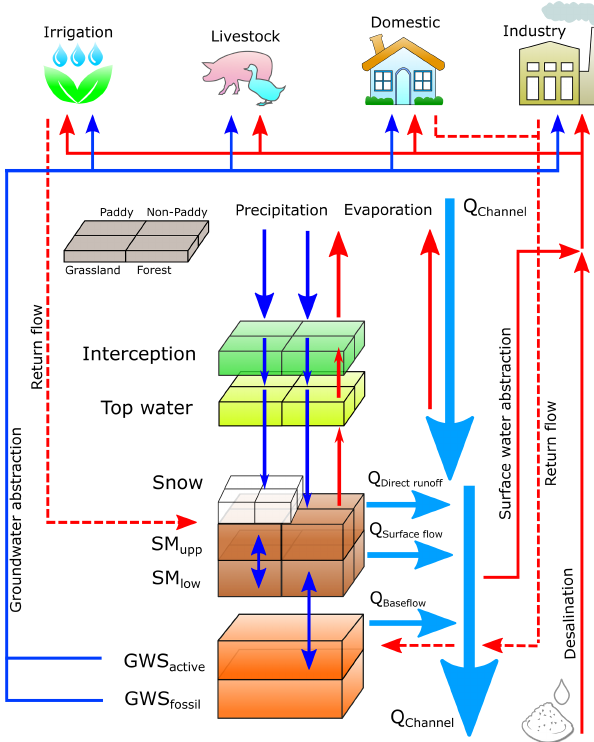
Figure 3. The structure of PCR-GLOBWB hydrological